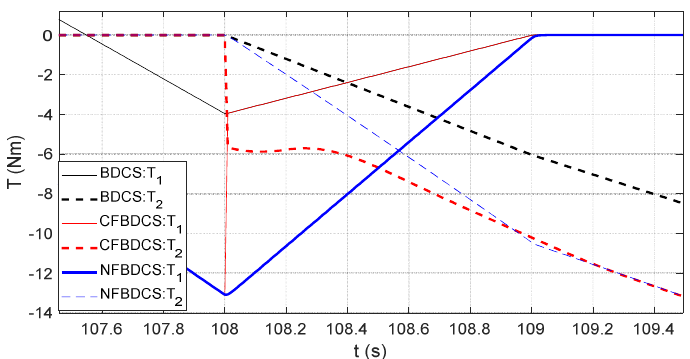
Figure 16. Torque profile from Mode 1 to Mode 2.